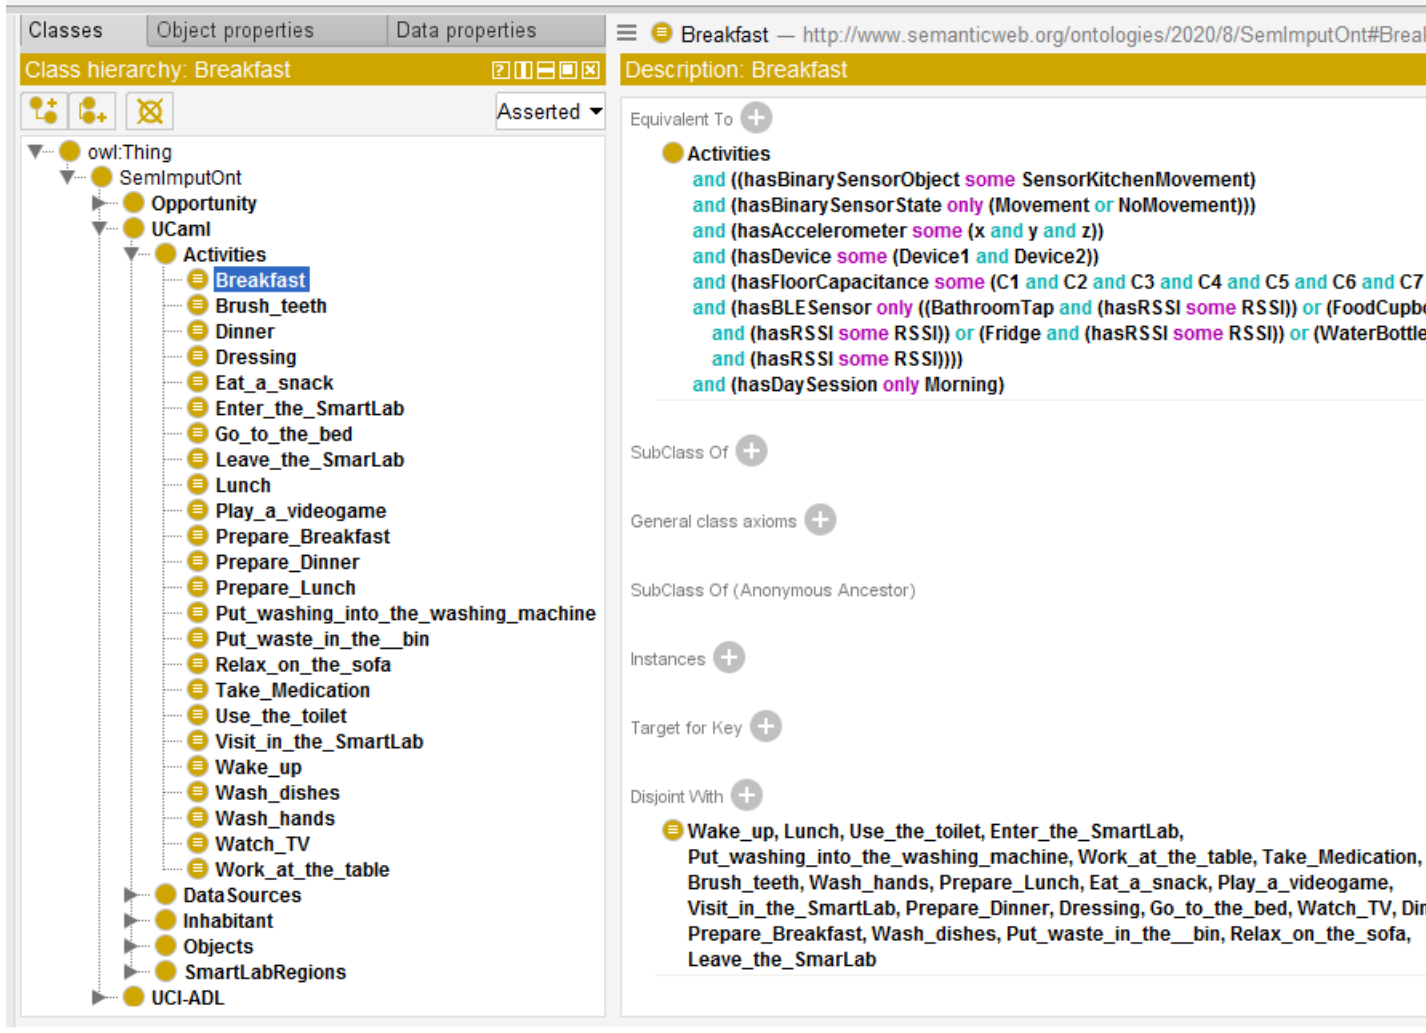
Figure 3. SemImputOnt : Class hierarchy with a definition axiom for the activity Breakfast